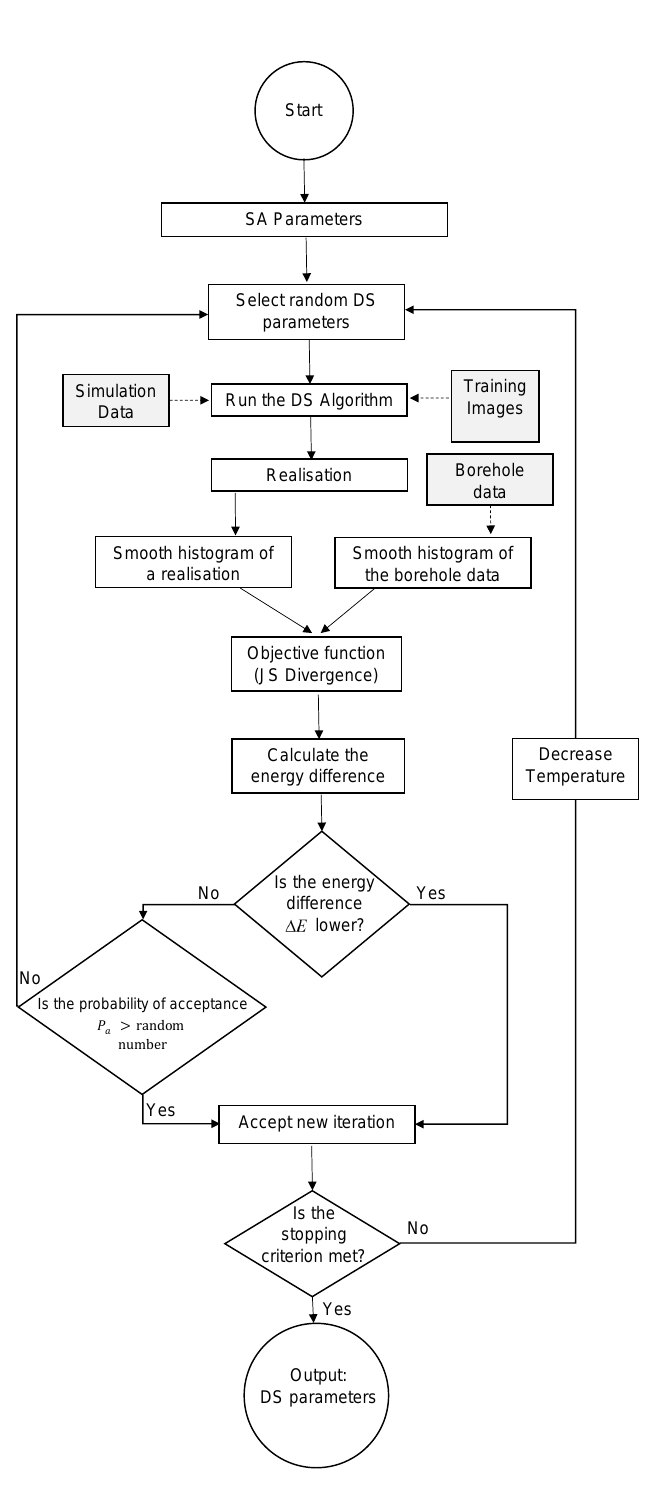
Figure 3. Flowchart of the